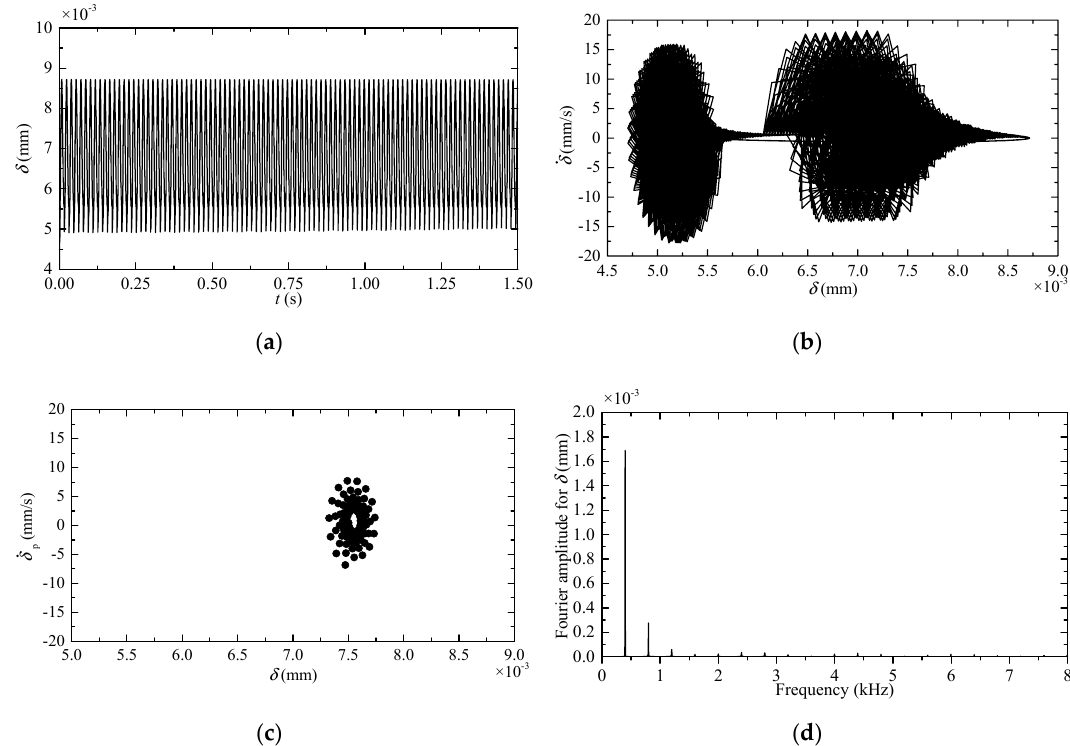
E E = ) is analyzed by comparing the (a) c s